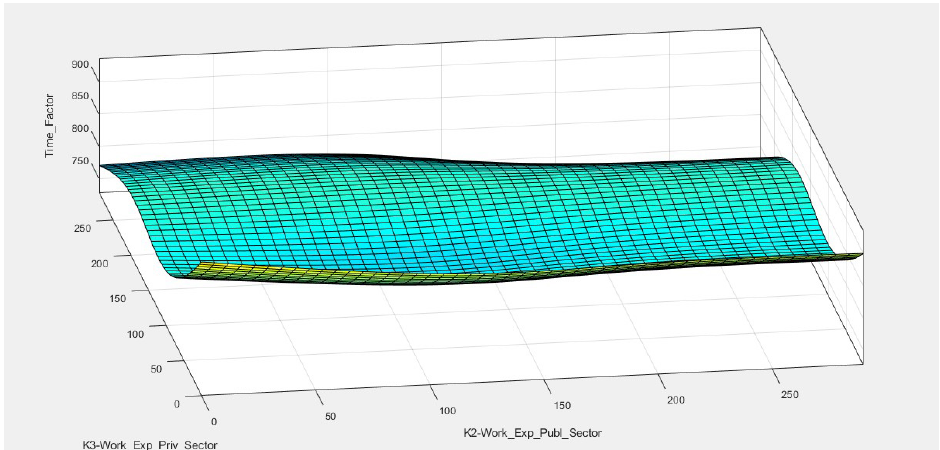
Figure 9. Results of work experience in public and private sector.